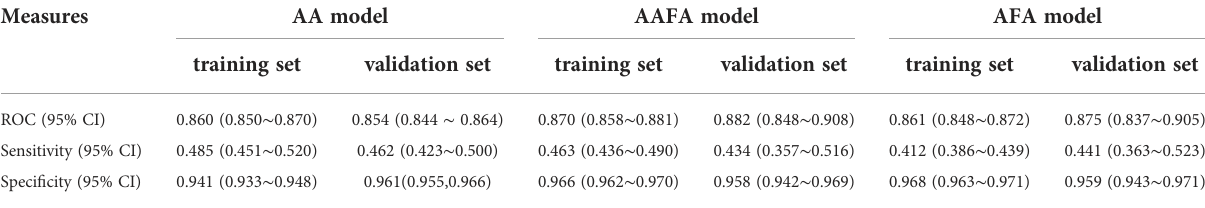
TABLE 4 The AUCs, sensitivity and speci fi city of AA, improved AAFA and AFA models in training (2017-2018 data) and external validation (2019 data) using the same grouping